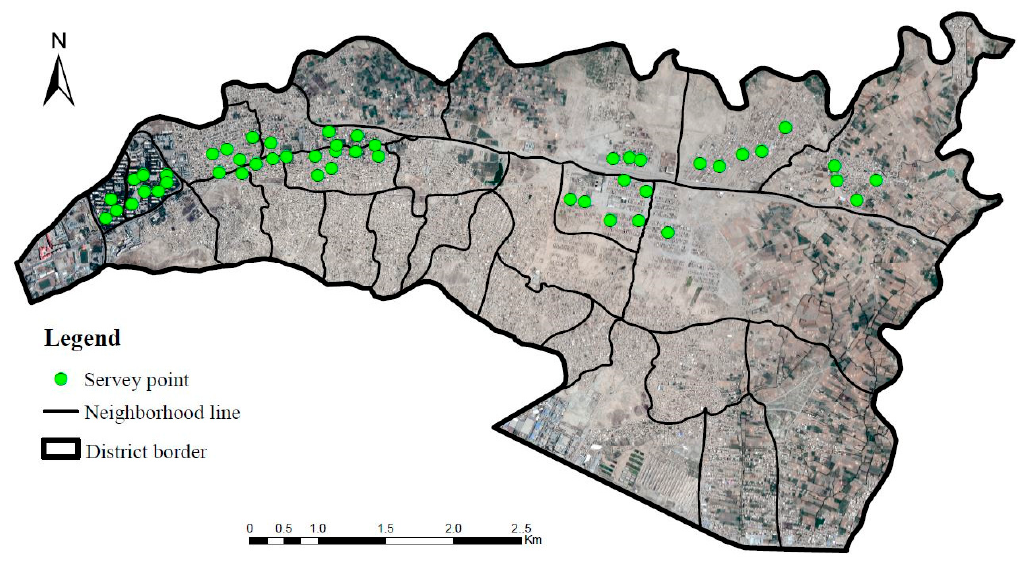
Figure 5. Map of District 16 with neighborhood boundaries and investigated sites.